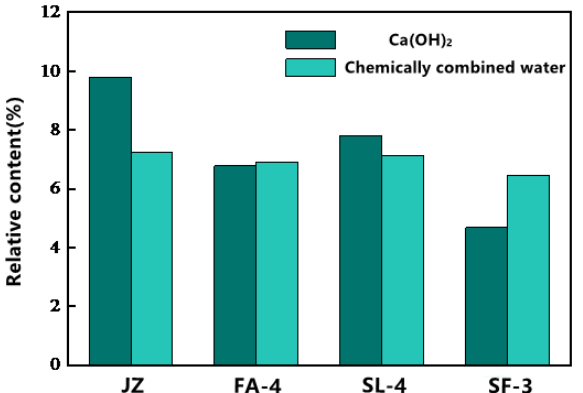
Figure 13. Content of chemically combined water and Ca(OH) 2 in cement mortar slurry.